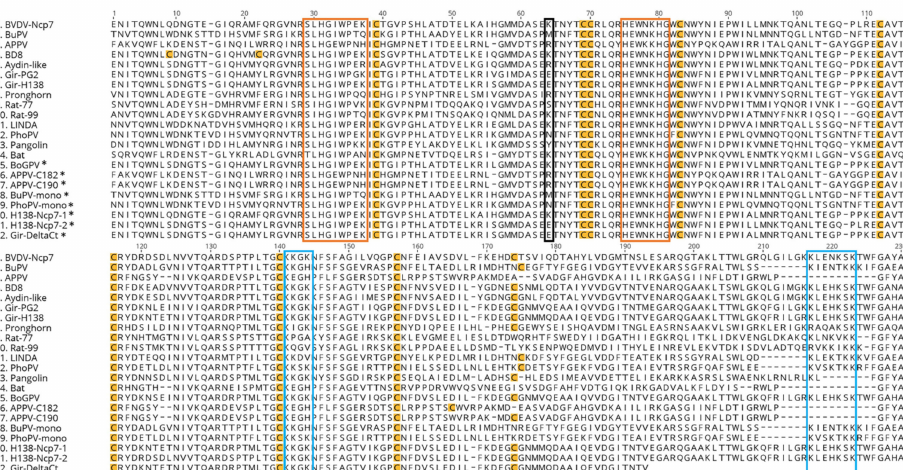
Figure 1. Amino acid alignment of the sequences of the E rns analyzed in this study. Sequences carrying the asterisk were not published elsewhere. The corresponding references and, where available, the GenBank numbers are reported in Table 1. To prevent the cleavage of the Strep-tag, the last four amino acids at the C-terminus of APPV-, Bat-, Rat77-, Rat99- and Pangolin-E rns , were modified in “GFYA”. In yellow are highlighted the cysteine (C) residues important for intra- and inter-molecular disulfide bridges. The orange boxes are focusing on the two RNase active sites conserved among most pestiviruses (except for APPV- and Bat-pestivirus), whereas the black box highlights the residue important for RNase activity as identified in this study using E rns of giraffe pestiviruses. The proposed “positive-region” and “heparin-binding-domain” [24] are boxed in